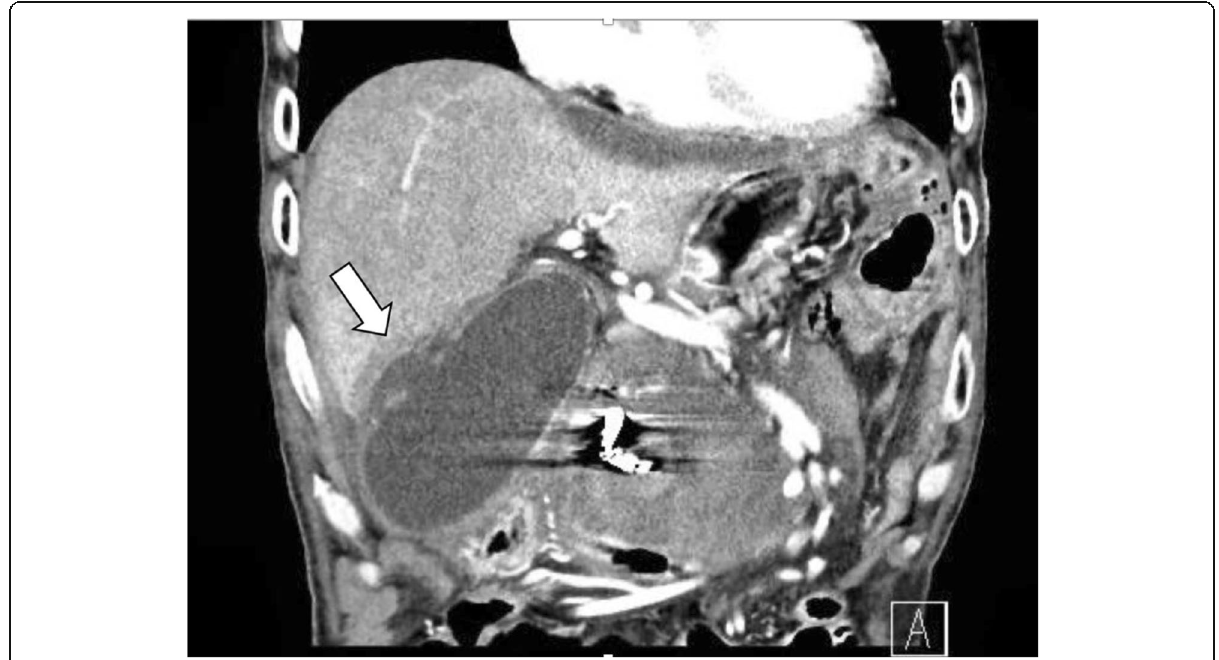
Fig. 3 Post-embolization computed tomography shows swollen gallbladder and encapsulated fluid retention around it (shown by arrow). It suggested that the wall was broken at the bottom of the gallbladder